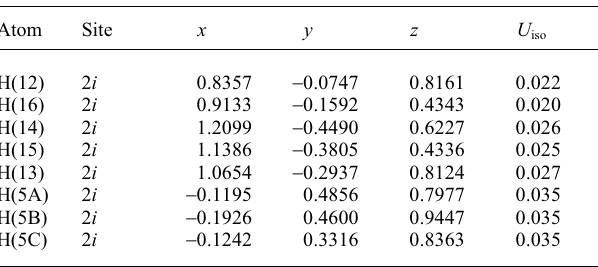
Table 2. Atomic coordinates and displacement parameters (in Å 2 )